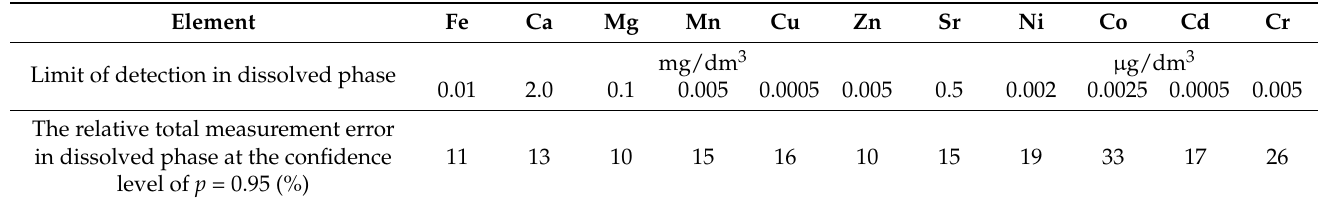
Table 2. Limits of detection and measurement errors in dissolved and particulate